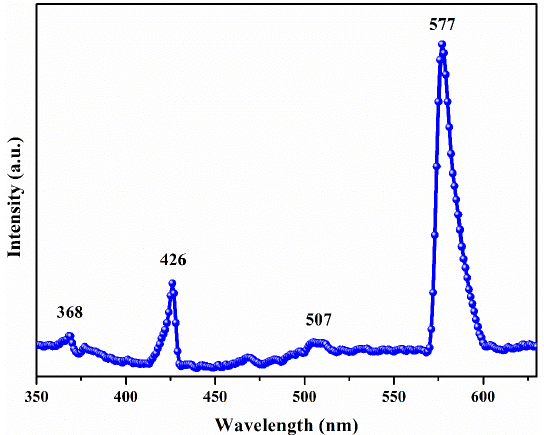
tric dipole transition of Co 2+ ions [30].